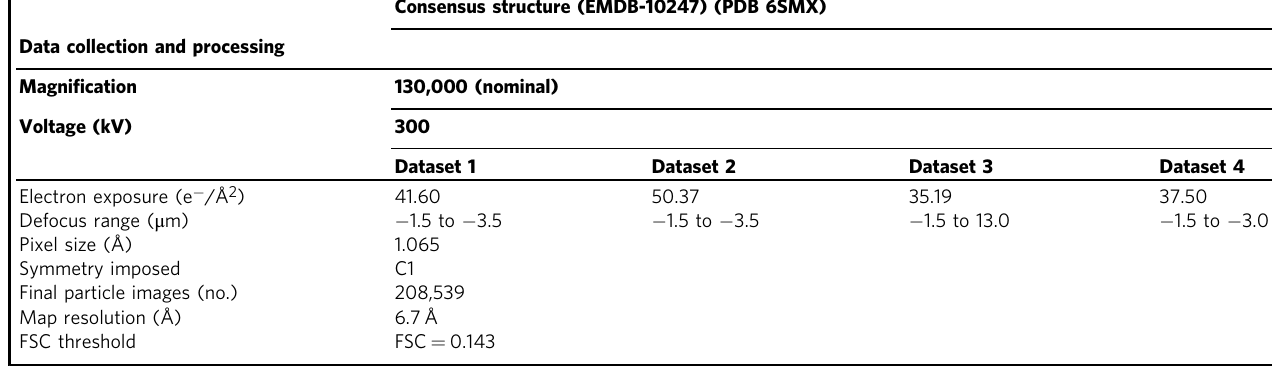
Table 1 Cryo-EM data collection